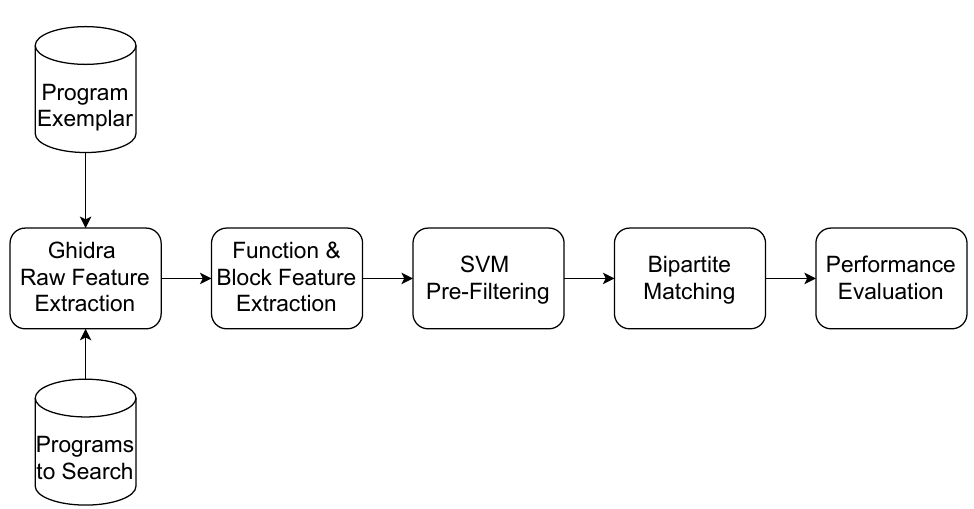
Figure 1. CCBVS Flow